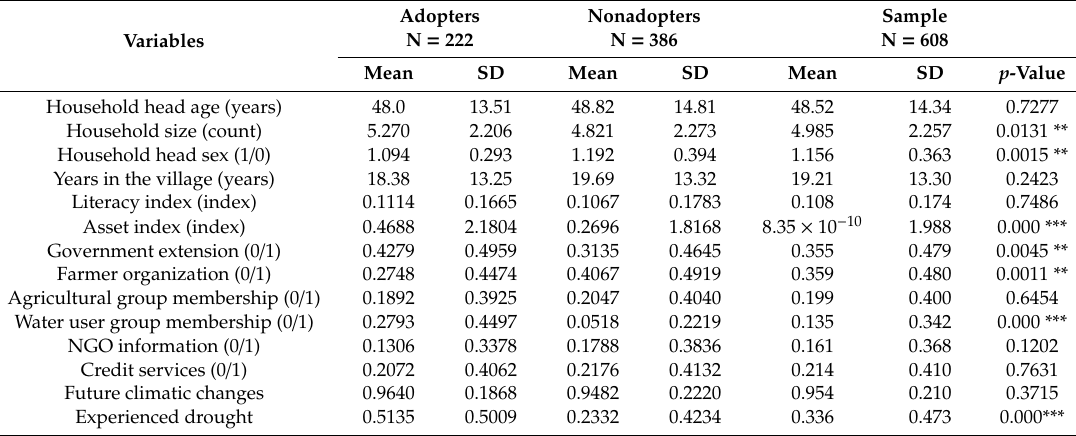
Table 1. Household descriptive